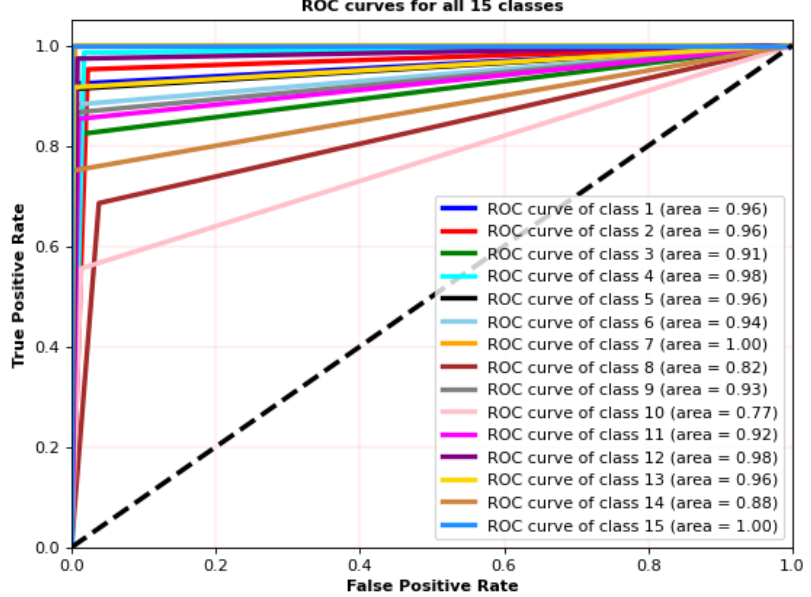
Figure 9. MobiAct_v2.0: individual ROC curves for all the classes, class 1 = walking, class 2 = stairs-up, class 3 = stairs-down, class 4 = stand-to-sit, class 5 = sit-to-stand, class 6 = car step-in, class 7 = car step-out, class 8 = forward lying, class 9 = back-sitting chair, class 10 = front-knees lying, class 11 = sideward lying, class 12 = jogging, class 13 = jumping, class 14 = standing, class 15 = sitting.